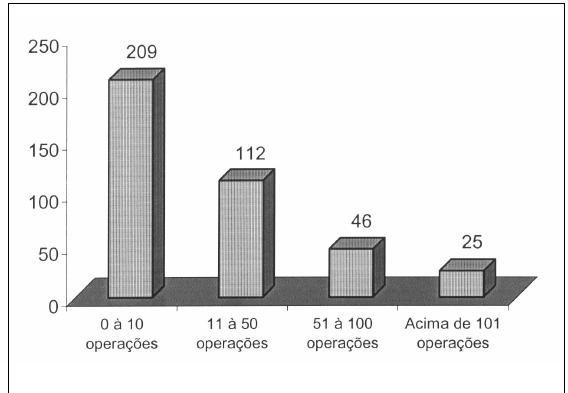
Fig. 2 - Distribuição dos médicos que realizaram os implantes, agrupa- dos por número de procedimentos realizados no ano de